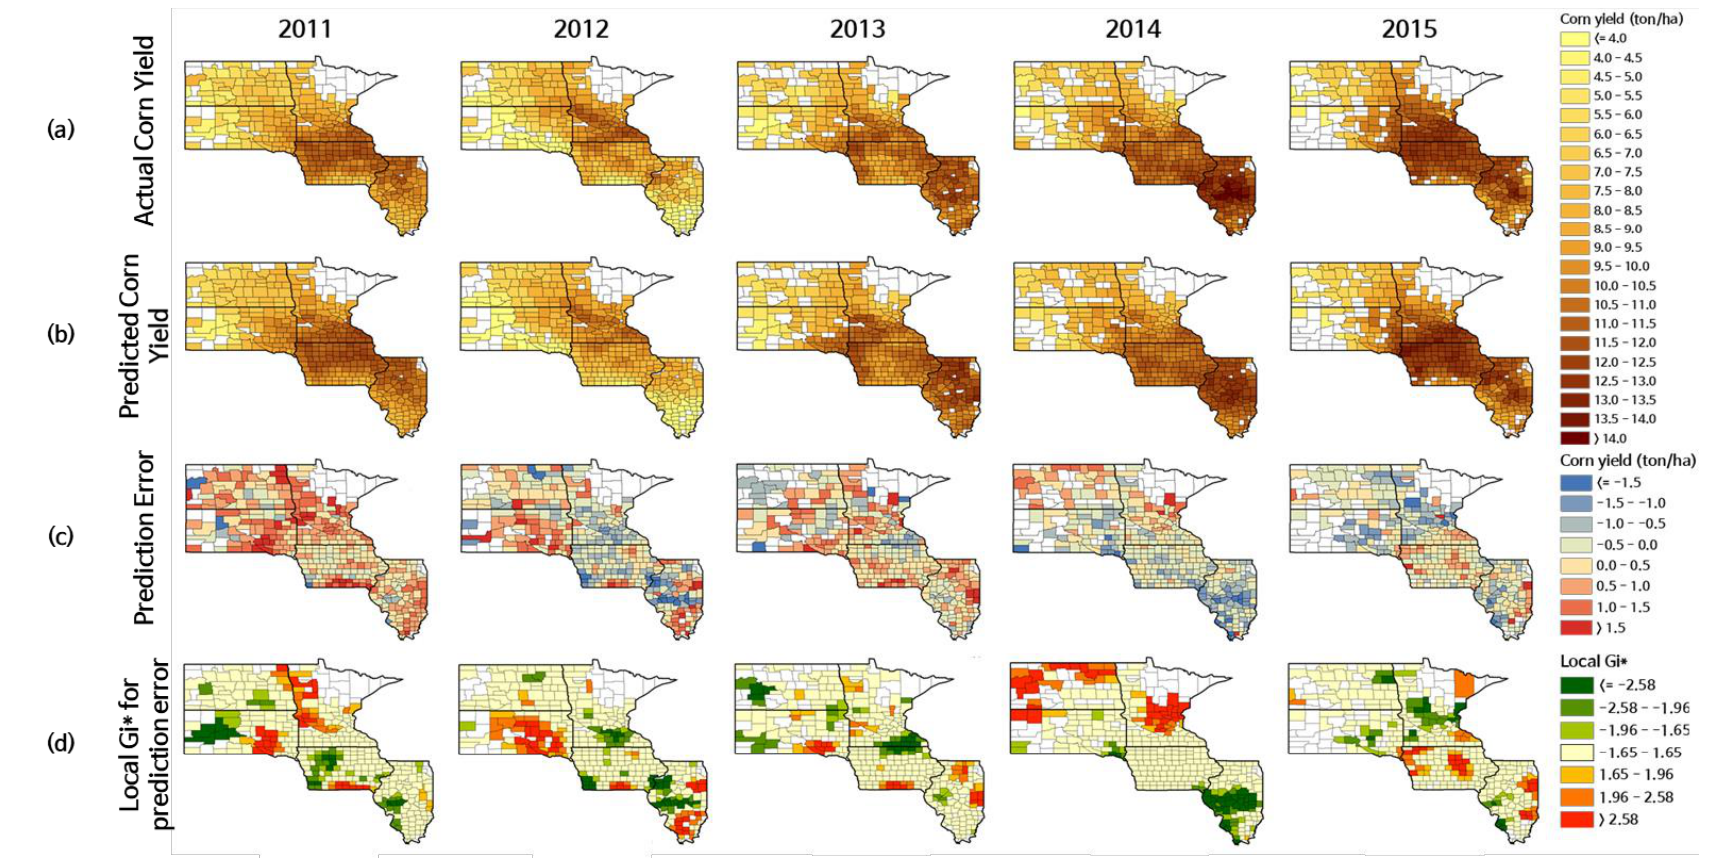
Figure 8. Maps of the actual and predicted corn yields, prediction errors, and Local Geary index (Gi*) of the prediction errors, 2011 – 2015.